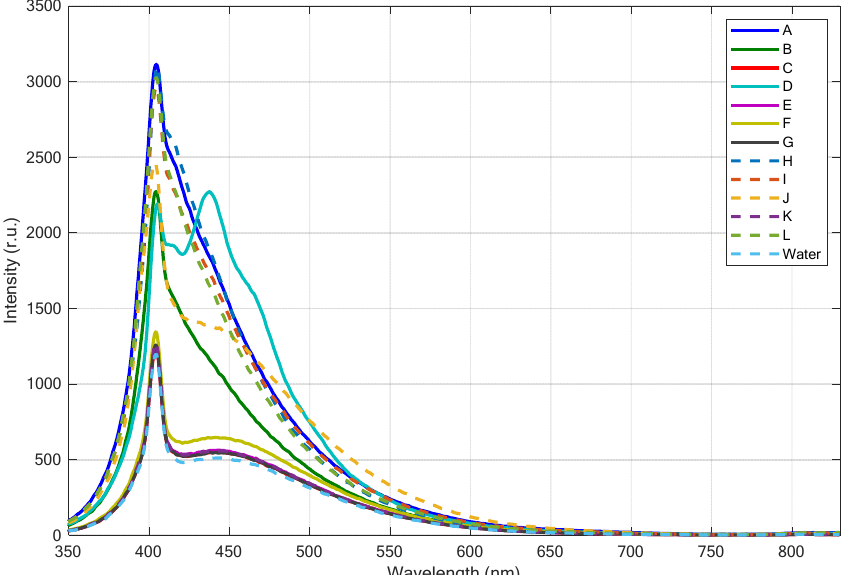
Figure 5. Fluorescence LIDAR spectra of samples A through L immersed in a 50 cm water column and, for comparison, the fluorescence LIDAR spectrum of the 50 cm water column (dashed cyan line).